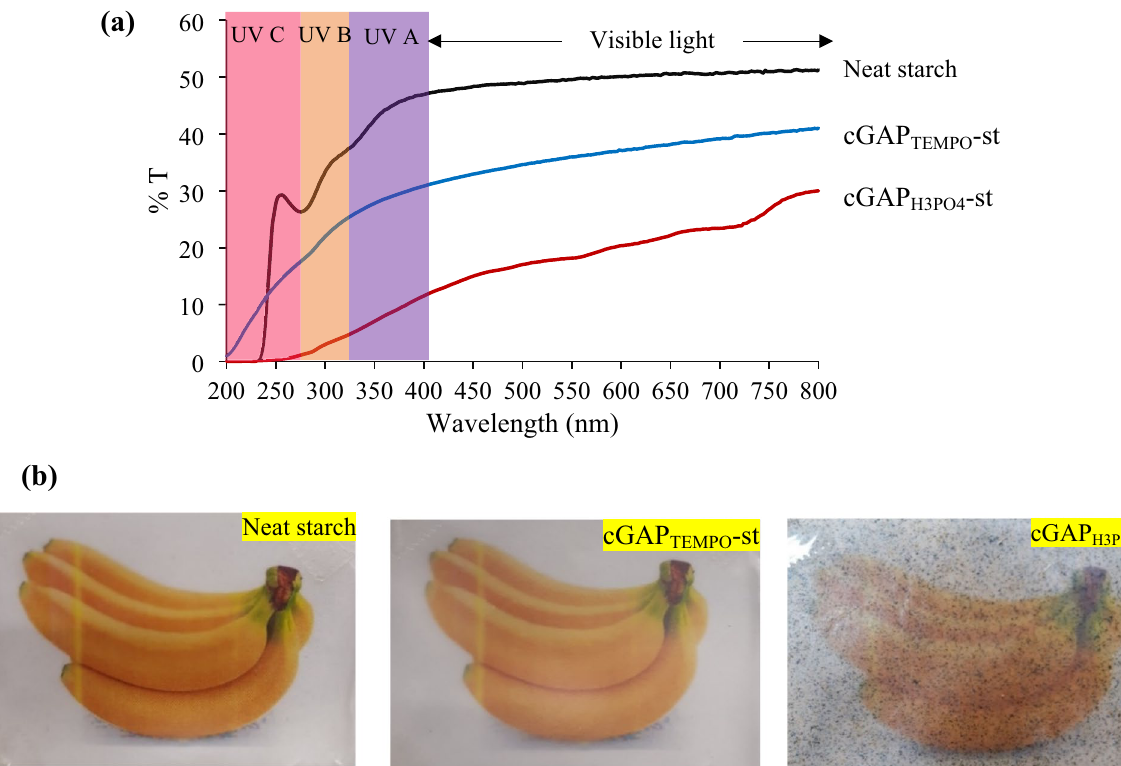
Fig. 6 Optical properties of starch–cGAP composite film: a UV–Vis light transmittance spectra, and b visual appearance of (i) neat starch film; (ii) cGAP TEMPO -st and; (iii) cGAP H3PO4